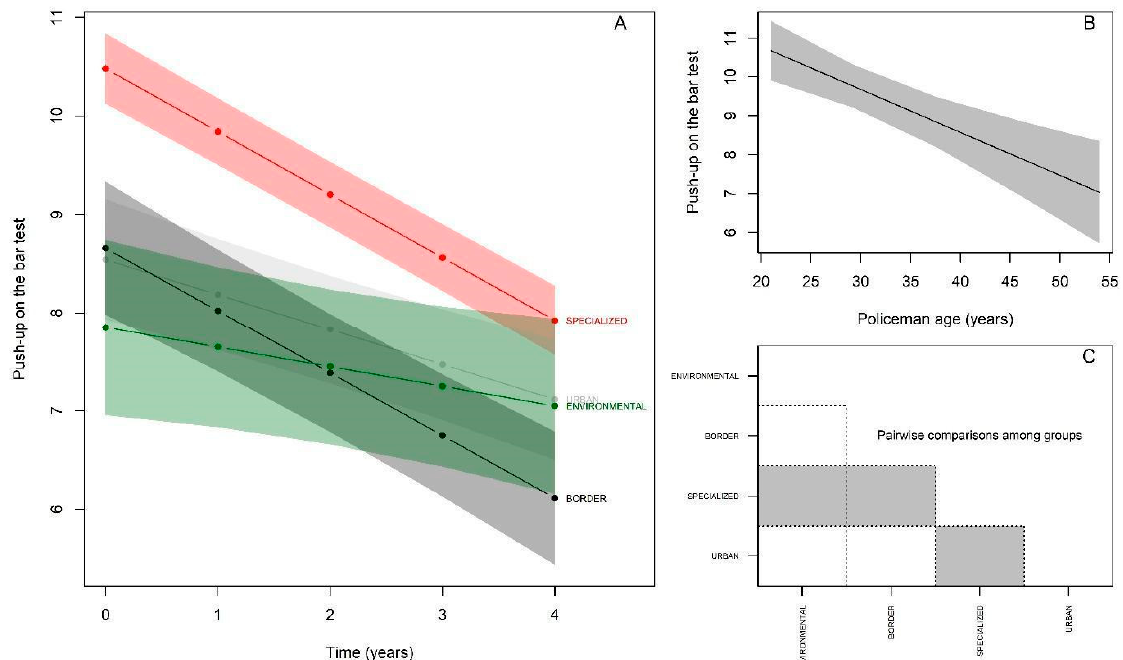
Figure 5. Performance behavior of police officers—Pull-ups. ( A ): Change in performance of maximum repetitions of pull-ups on the bar over 5 years according to police specialties; ( B ): Performance in maximum repetitions of pull-ups on the bar by police officers in relation to age; ( C ): Comparison of performance on the push-up test between police specialties at baseline (gray color indicates significant difference between the respective groups). Table 5. Statistical summary and model-estimated coefficients of the effect of group, time, and age on performance in the push-up on the bar.